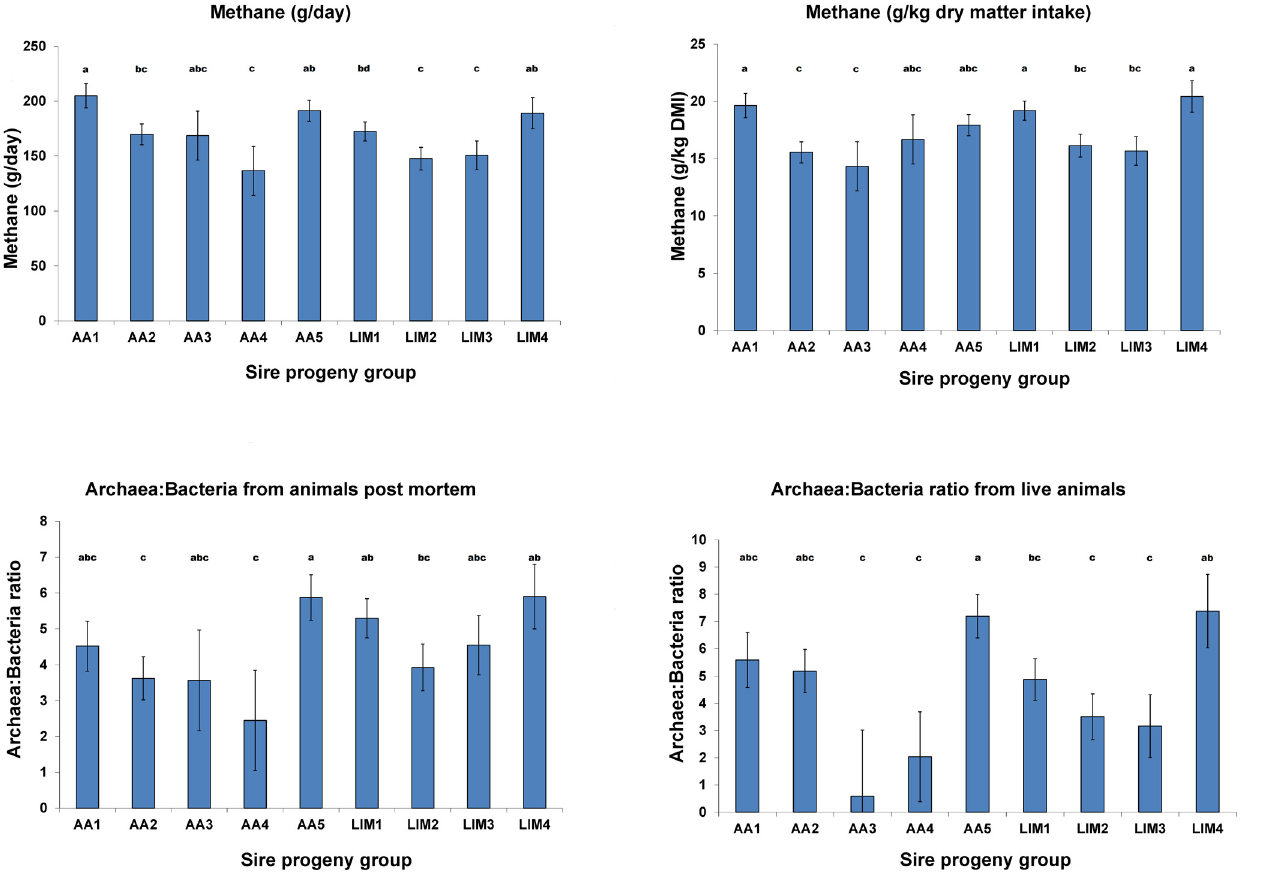
Fig 2. Host genetic effects on methane emissions and relative microbial abundance. Host genetic effects were estimated by least squares means ( ± standard errors, different letters above bars indicate significant different estimates) of sire progeny groups (AA = Aberdeen Angus sired, LIM = Limousin sired) adjusted for diet, respiration chamber and randomized block effects. Relative microbial abundance was calculated as archaea:bacteria ratio.